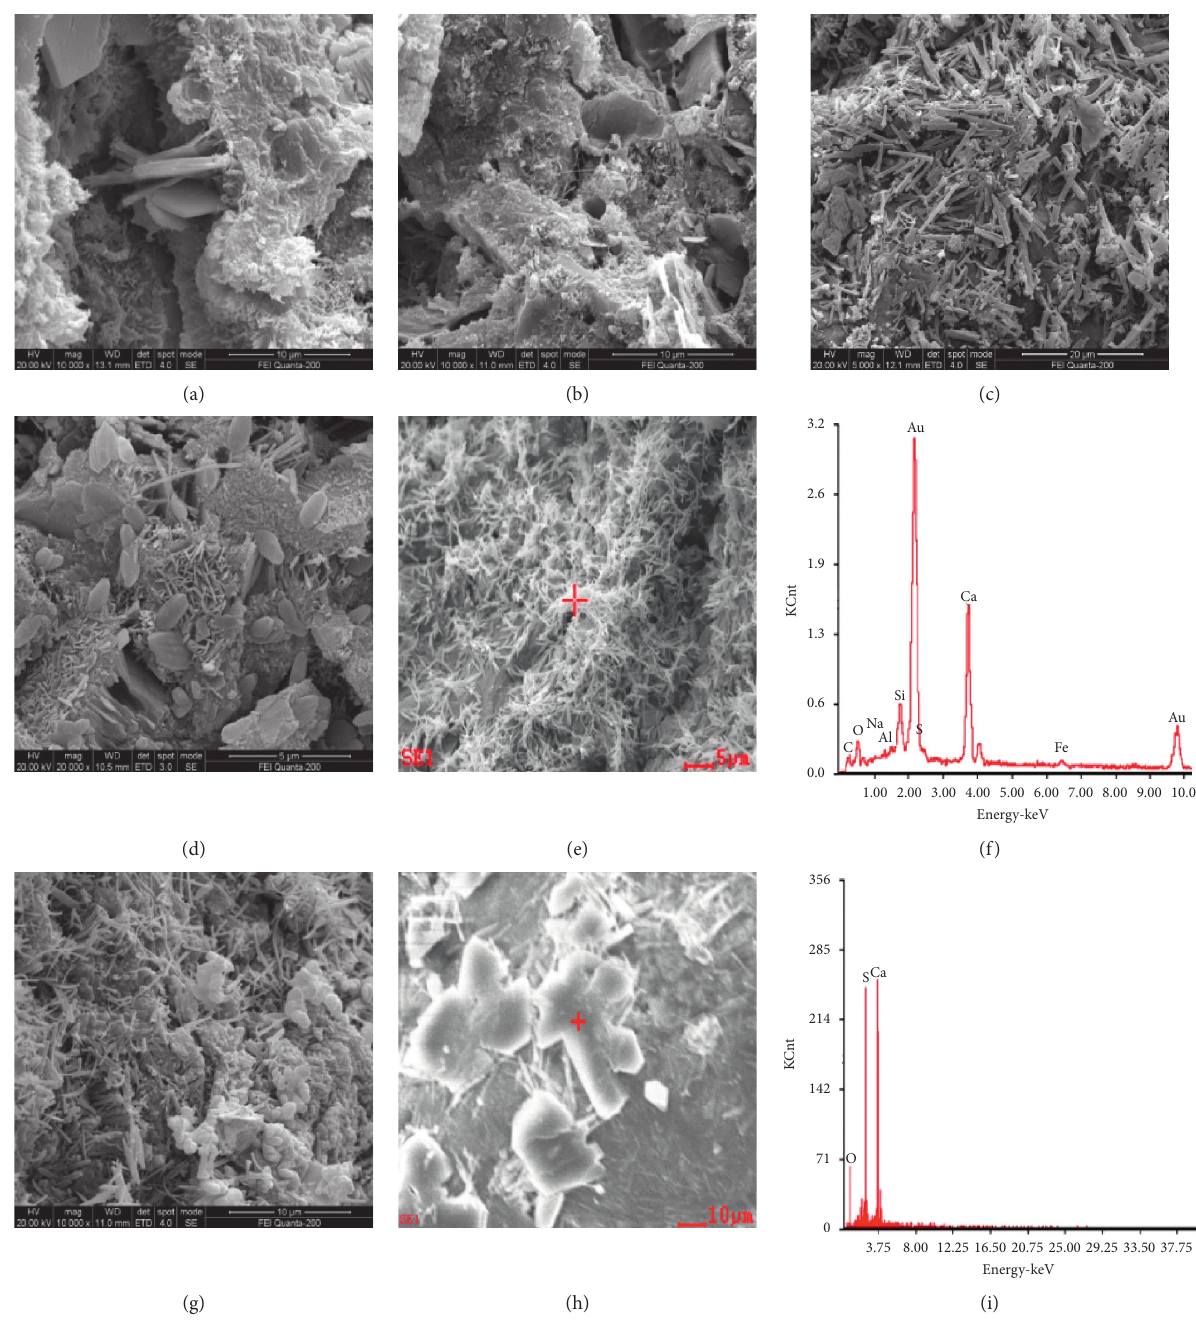
Figure 6: ESEM-EDS spectra of cement and concrete attacked by sulfate solution of different concentrations. (a) Non attacked. (b) 1%. (c) 5%. (d) 10%. (e) 10%. (f) EDS analysis. (g) 20%. (h) Saturated solution. (i) EDS